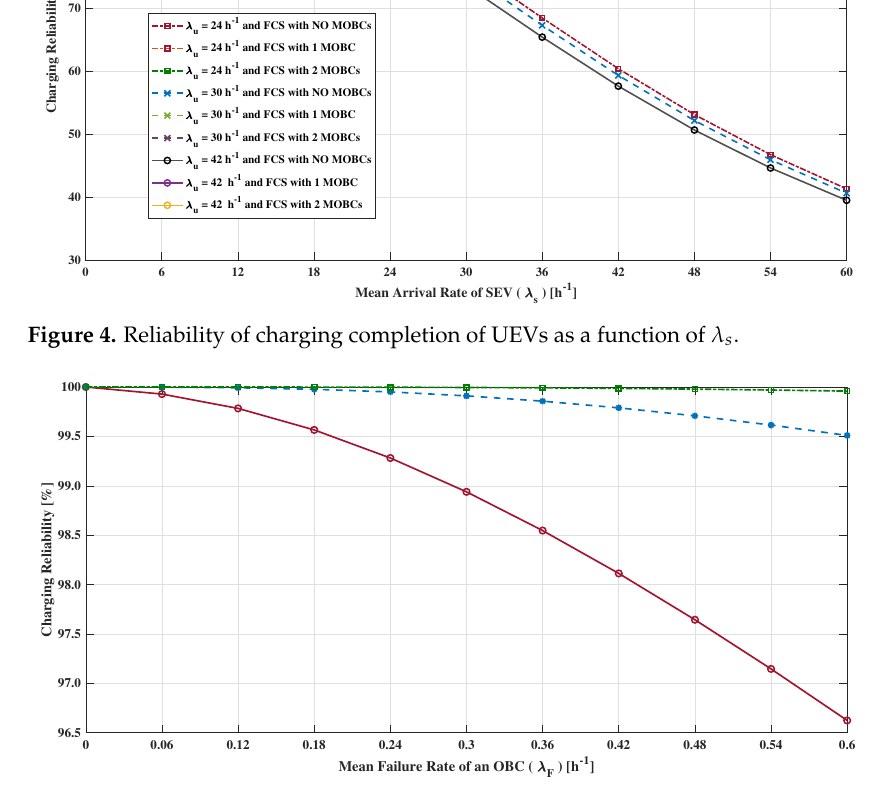
Figure 5. Reliability of charging completion of SEVs as a function of λ F